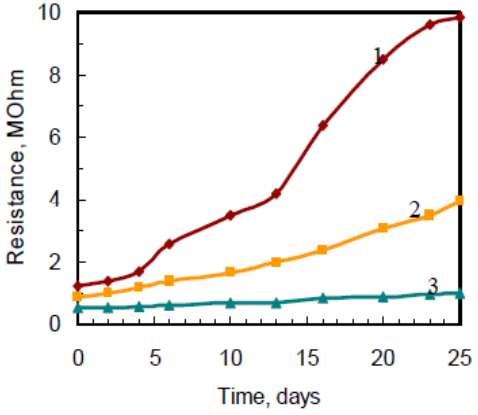
Figure 3. Typical stability dependence of emeraldine state films activated with H 6 P 2 W 18 O 62 on relative humidity in air at room temperature: 1–95%, 2–15%, 3–55%.